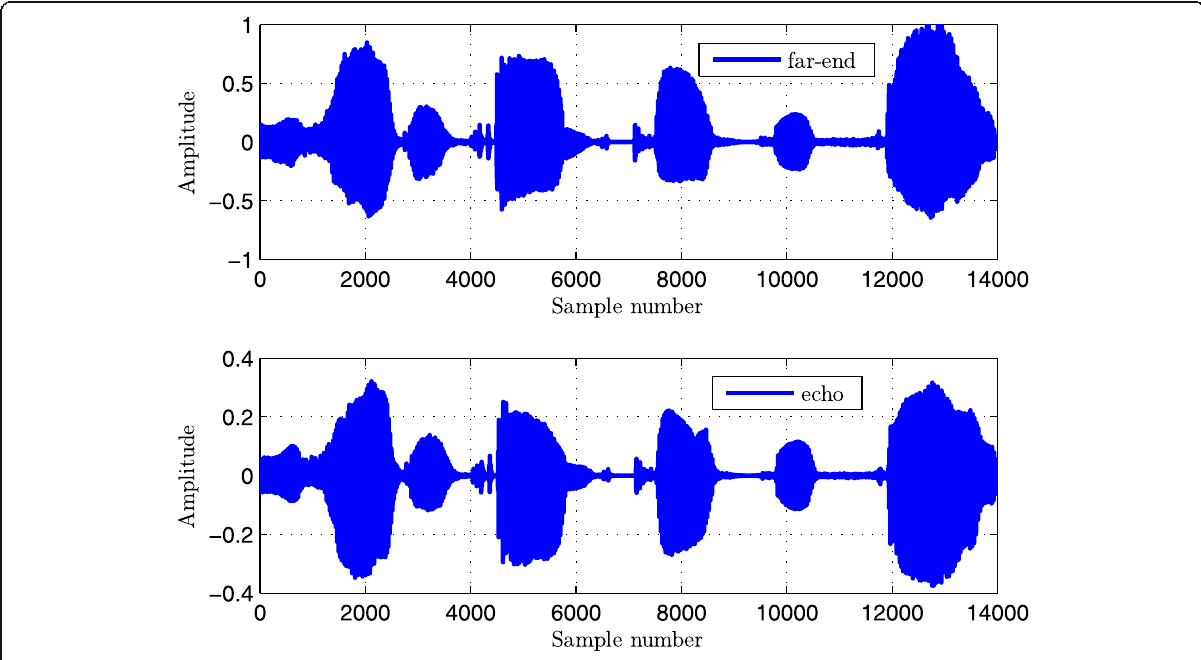
Fig. 14 Far-end signal from real speech and echo